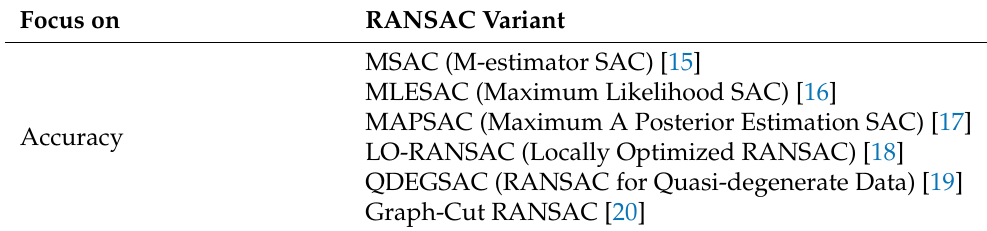
Table 1. RANSAC variants grouped by the metric they aim to improve. Focus